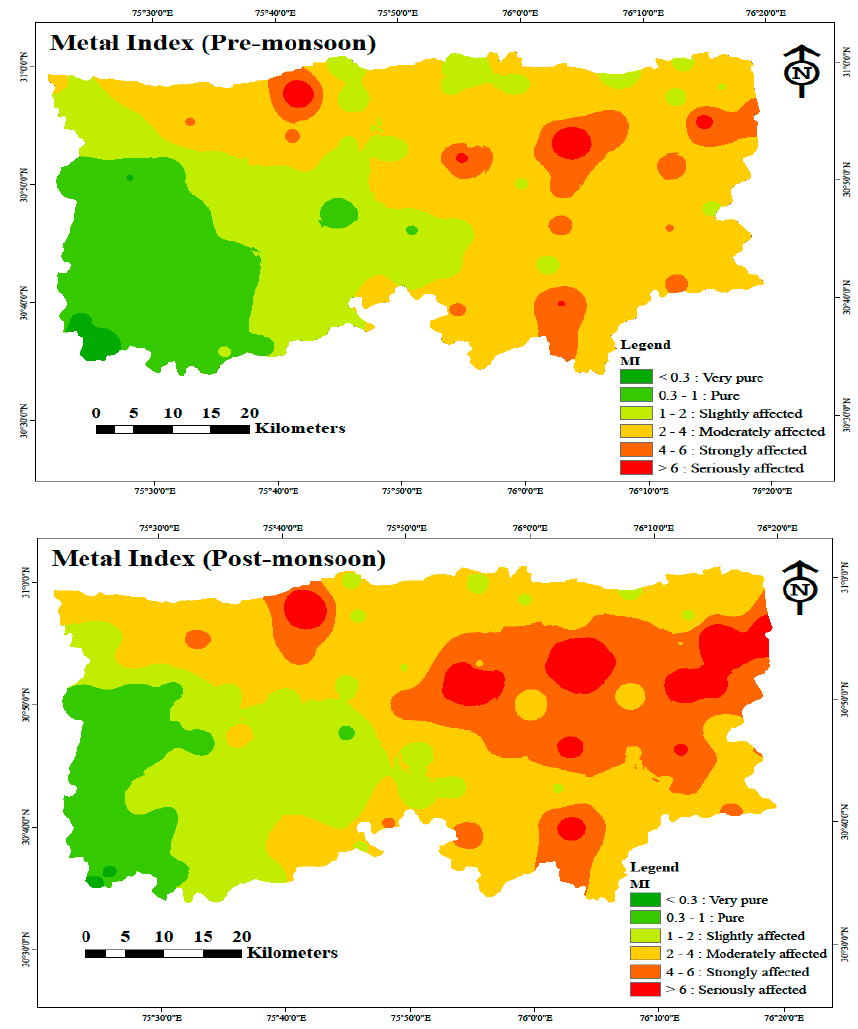
Figure 4. Geospatial variation of the MI during pre- and postmonsoon periods.